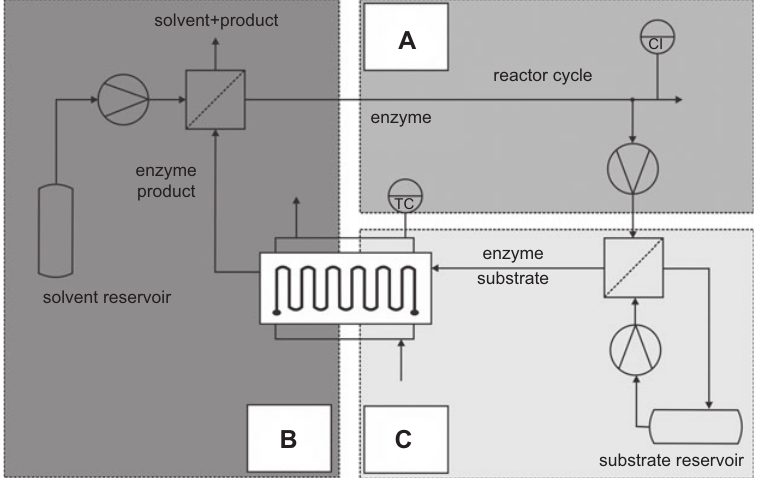
Figure 13 Possible flow scheme for the continuous analysis of the combined unit operations introduced. The reactor cycle with a sampling valve as well as two membrane cycles for substrate feed and product removal is